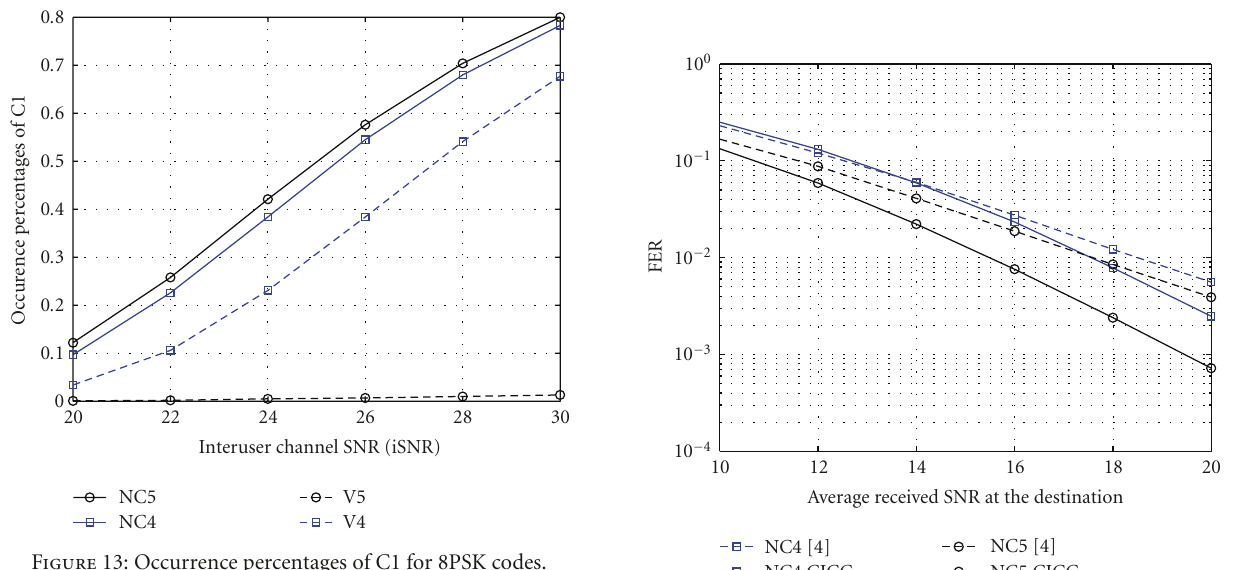
Figure 14: Performance comparison of the proposed QPSK codes for classical [4] and CI coded cooperation.